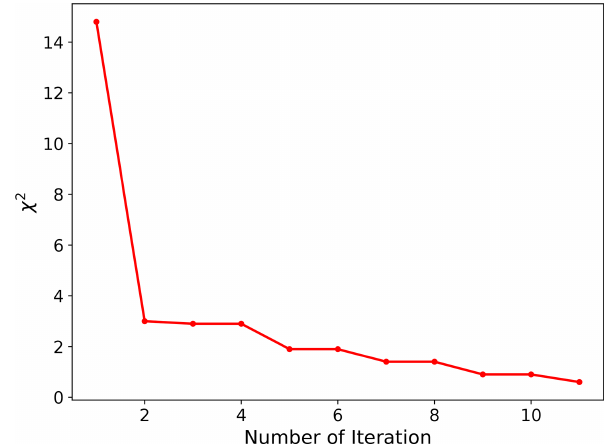
Figure 9. Histogram of data-fit error, which is defined as ratio of the residual resistance (difference in the observed and predicted re- sistances) and observed resistance expressed as a